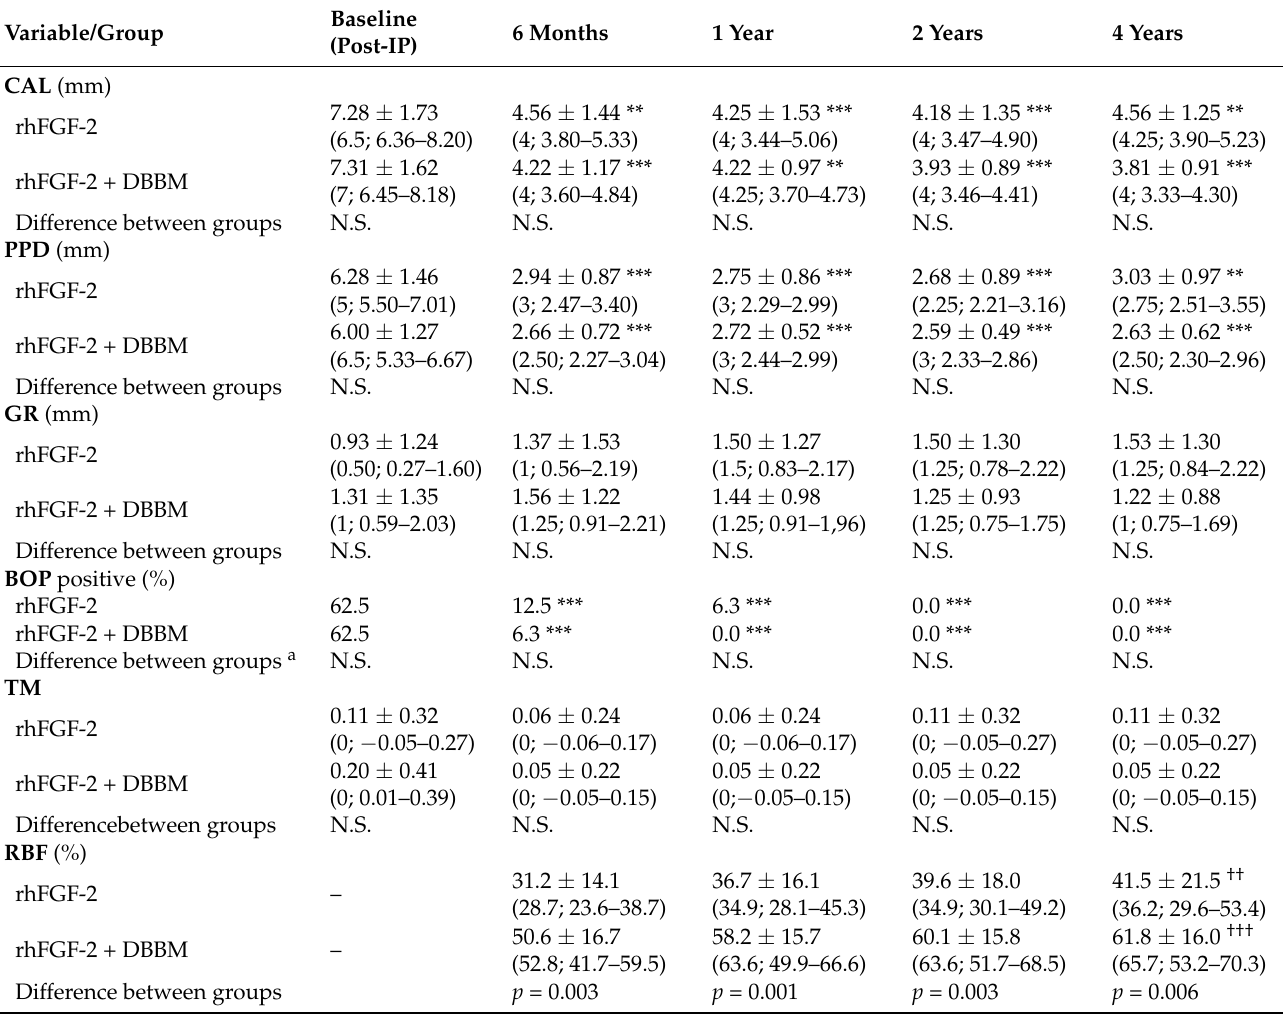
Table 2. Clinical and radiographic outcomes of control (rhFGF-2) and test (rhFGF-2 + DBBM) groups (total n = 32 sites).